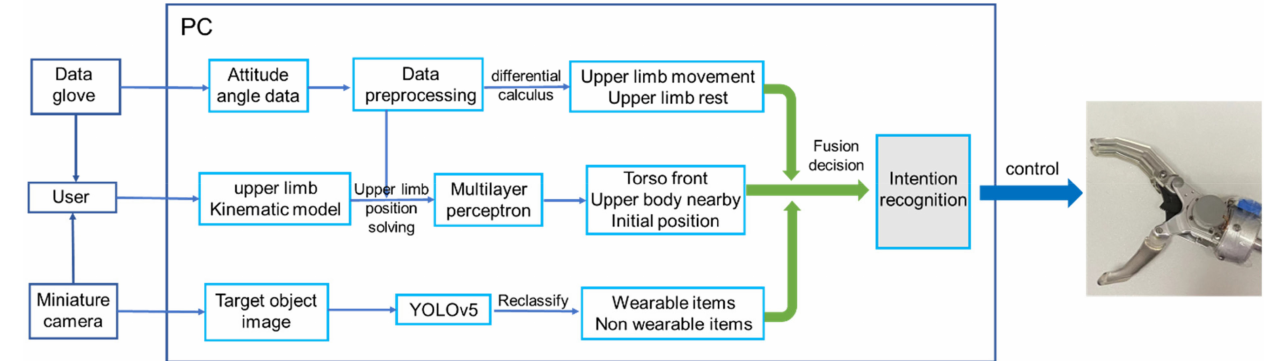
Figure 7. Complete control system